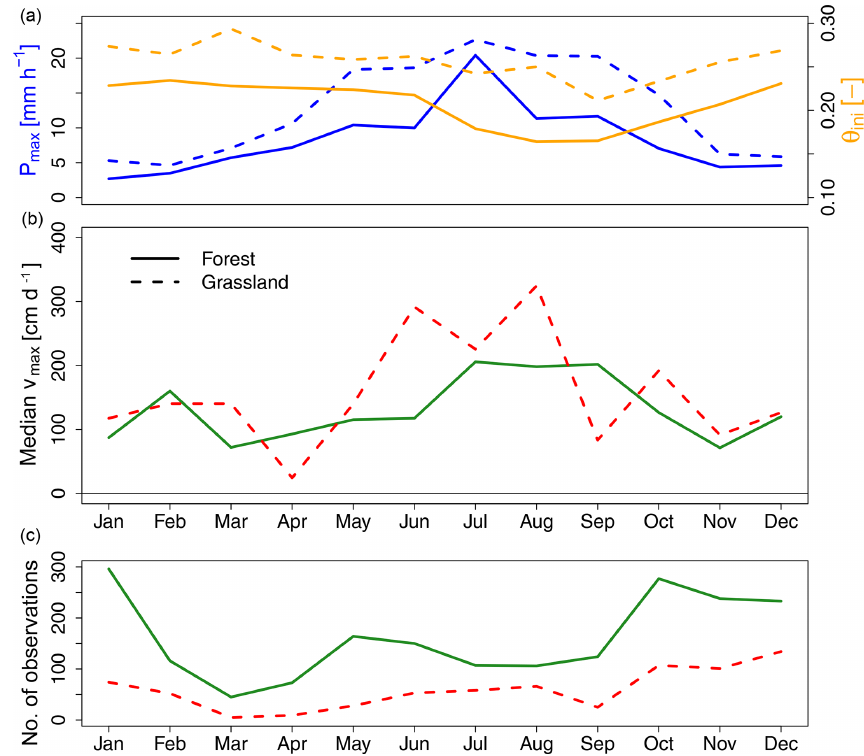
Figure 12. Monthly mean P max and θ ini (a) , monthly median v max for the two land covers (b) and number of observed v max values (SR that reached either 30 or 50cm) for each land cover and month (c) . The solid lines represent the forest and the dotted lines the grassland